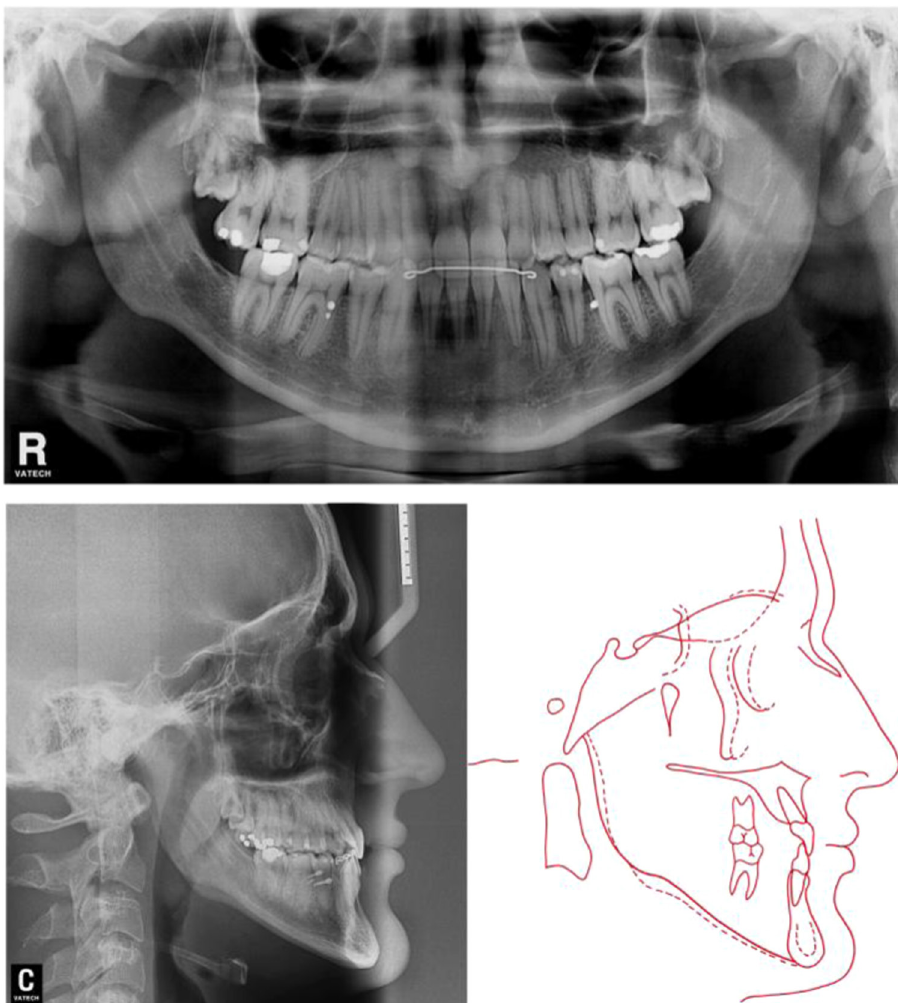
Figure 4. Posttreatment